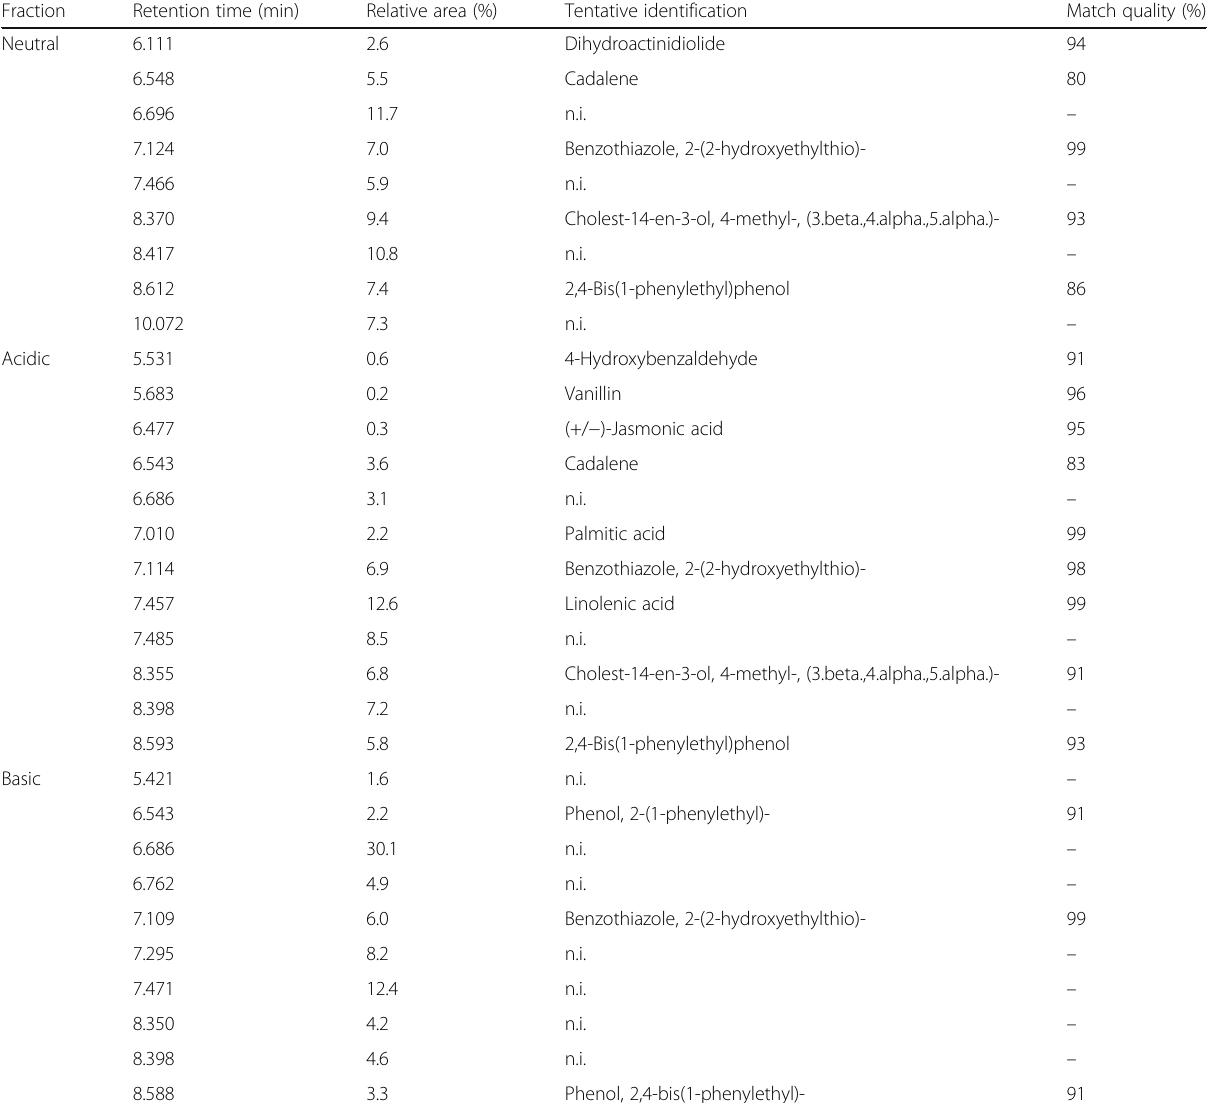
Table 1 GC-MS analysis of the volatile components presented in the S. asper fractions Fraction